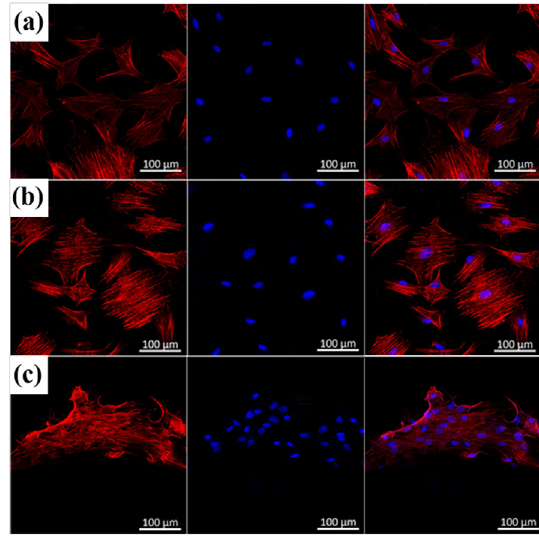
Fig. 14 Fluorescence images (200×) rBMSCs stained with DAPI and rhodamine-phalloidin on HA plates sintered at 1300 in differen ℃ t atmospheres and p-cell samples sintered at 1300 ℃ in wet CO 2 after 3 days of culture: (a) plates sintered in air, (b) plates sintered in wet CO 2 , and (c) p-cell samples sintered in wet CO 2